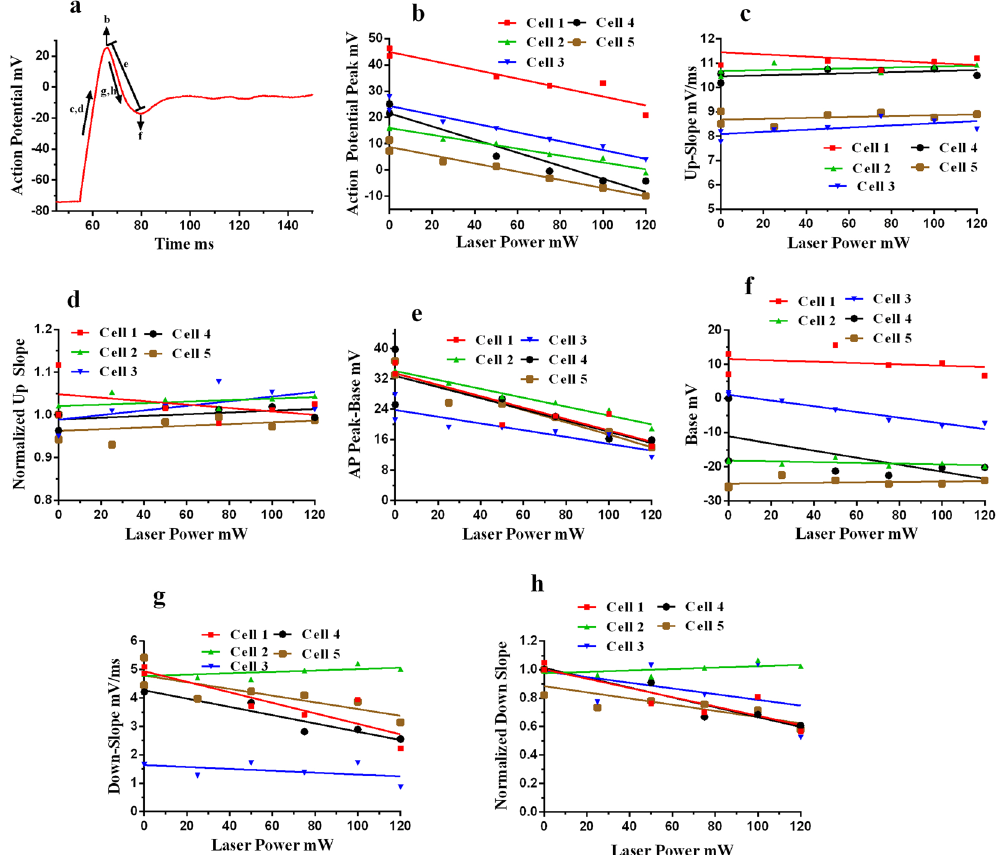
Figure 6. Analysis of inhibition experiments. ( a ) A representative figure indicating the various analyses done for inhibition experiments as function of laser power, shown in subsequent parts. ( b ) Action potential peak decreases as the laser power increases, shown for five different cells. ( c ) The rate of rise of action potential (mV/ ms) remains unaffected by the laser power as shown in up-slope vs laser power curves for five different cells. ( d ) All the up-slope values were normalized with initial up-slope (Pre-AP up-slope) which shows same trend of having no change with laser power like absolute values in ( c ). ( e ) The difference between AP peak and base value (first minima after peak) decreases with laser, because of the decrease in peak values of AP ( b ). ( f ) The base value (first minima) remains the same, doesn’t vary with laser power. ( g , h ) The down-slope and normalized downslope (downslopes normalized with downslope of pre-AP down-slope) decrease with laser power. The points with zero laser power belongs to electrical stimulations alone, control condition.